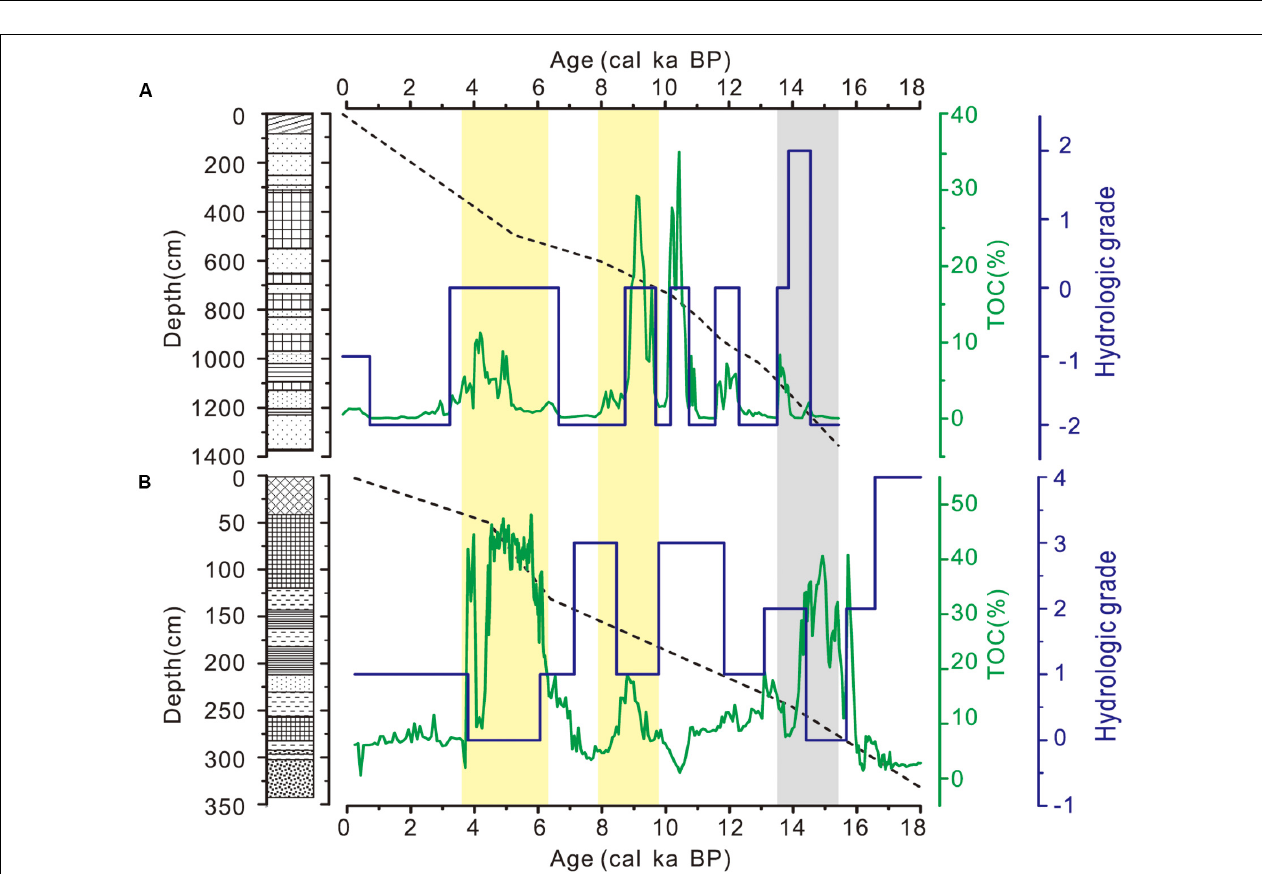
FIGURE 6 | Variations in hydrological conditions and carbon accumulation in two peatlands since the Last Deglaciation ( A for MDW and B for DH). Blue lines are the reconstructed hydrological conditions of two sites, green lines are for the carbon accumulation, dashed lines are for the depth-age relationships of two sections, light yellow bars are the in-phase pattern for carbon accumulation and the anti-phase pattern for hydrology in the two sites, and the light gray bar indicates the in-phase pattern for hydrology in the two sites in the interval from 15 to 13.5 cal. ka BP.